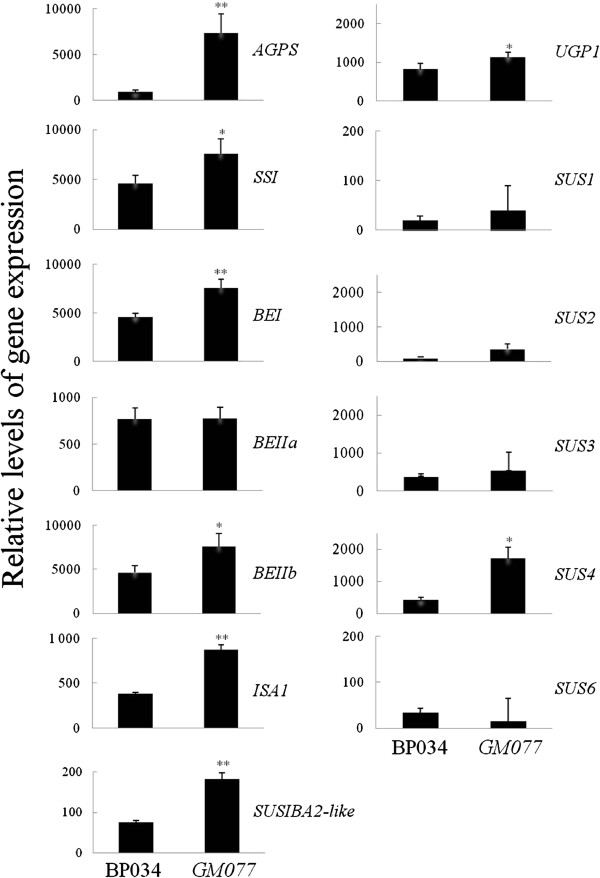
qPCR analytic results of gene expression levels for 13 detectable genes potentially involved in carbon portioning between starch and other carbohydrates. Biological triplets (seeds of 12 days after flowering from three different plants) and technical triplets were performed. The difference between BP034 and GM077 was analyzed statistically by the ANOVA test and presented as “increased” (*P < 0.05) and “significantly increased” (**P < 0.01) between the two rice cultivars. Error bars are as indicated. AGP (gene for ADP-glucose pyrophosphorylase), UGP (gene for UDP-glucose pyrophosphorylase), SS (gene for starch synthase), SUS (gene for sucrose synthase), BE (gene for branching enzyme), ISA (gene for isoamylase), SUSIBA2-like (gene for sugar signaling in barley 2 - like).